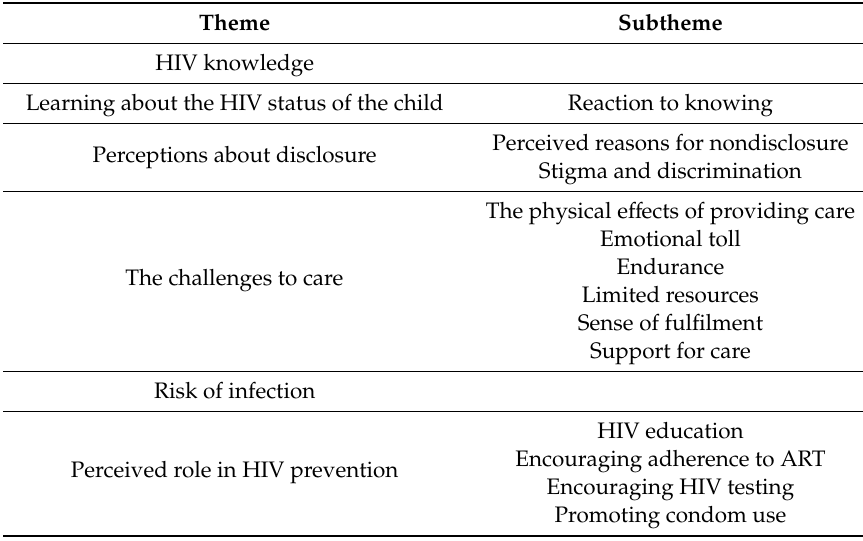
Table 2. Summary of themes and